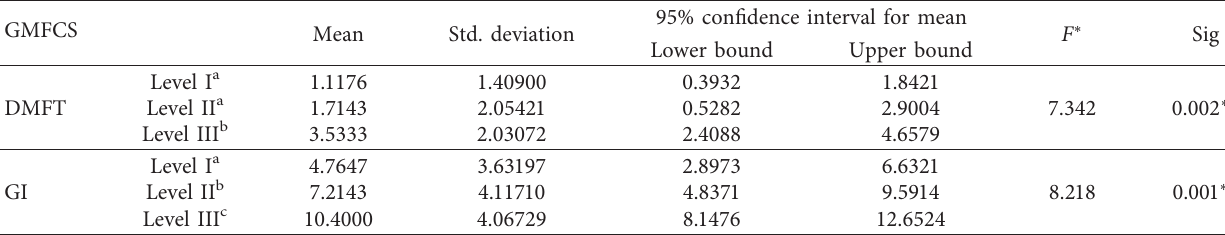
Table 4: Impact of functional ability on oral health.